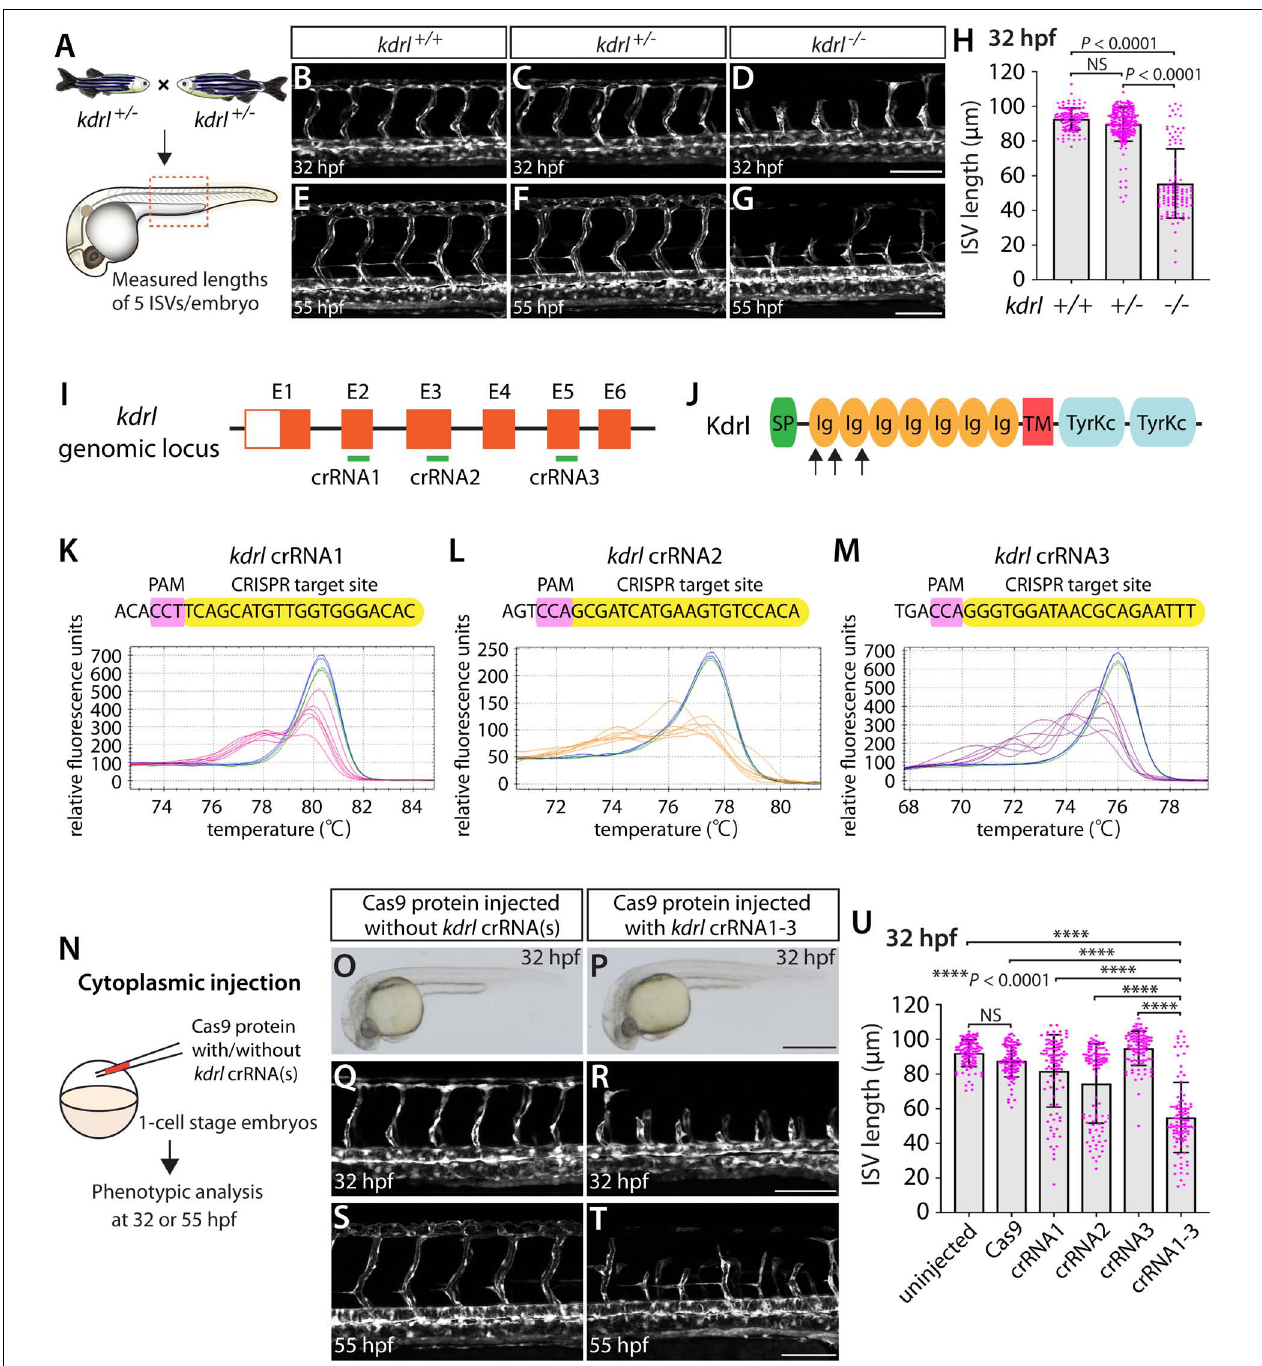
FIGURE 1 | Embryos injected with the triple dgRNPs targeting kdrl exhibited aISV defects similar to those observed in kdrl − / − fish. (A) Experimental setup for the phenotypic analysis presented in panels (B–H) . Adult kdrl + / − fish were incrossed, and progeny generated from the crosses were imaged to quantify the lengths of their arterial intersegmental vessels (aISVs) at 32 hpf. (B–G) Lateral views of kdrl + / + (B,E) , kdrl + / − (C,F) , and kdrl − / − (D,G) trunk vasculature visualized by Tg(kdrl: EGFP ) expression at 32 (B–D) and 55 (E–G) hpf. (H) Quantification of aISV lengths in kdrl + / + , kdrl + / − , and kdrl − / − embryos at 32 hpf ( n = 23 for kdrl + / + , n = 45 for kdrl + / − , and n = 21 for kdrl − / − fish). Lengths of 5 aISVs per embryo were measured. NS: not significant. (I) Three synthetic CRISPR RNAs (crRNAs) were designed to target sequences within exon 2 (E2), E3, and E5 on the kdrl genomic locus. (J) Predicted domain structure of zebrafish Kdrl. Kdrl consists of a signal peptide (SP), seven immunoglobulin-like domains (Ig), a transmembrane domain (TM), and two tyrosine kinase domains (TyrKc). Arrows indicate the approximate positions of the protein sequences corresponding to the target sequences of the three designed crRNAs. (K–M) High-resolution melt analysis (HRMA) used to validate the efficacy of the three designed crRNAs. The melting curves of 6 independent embryos injected with the dgRNP complex containing kdrl crRNA1 ( K, pink), crRNA2 ( L, orange), or crRNA3 ( M, purple) are presented. The melting curves of 2 independent, uninjected ( K–M, blue) and Cas9